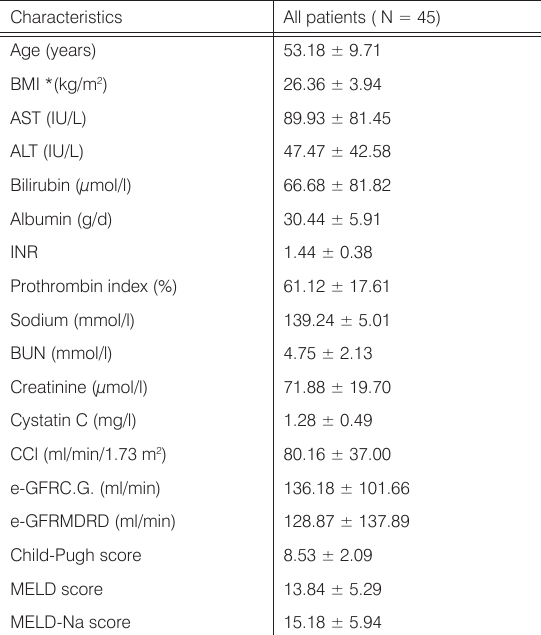
Table 1. Baseline characteristics of the enrolled patients with liver cirrhosis and normal serum creatinine levels (mean ± SD).